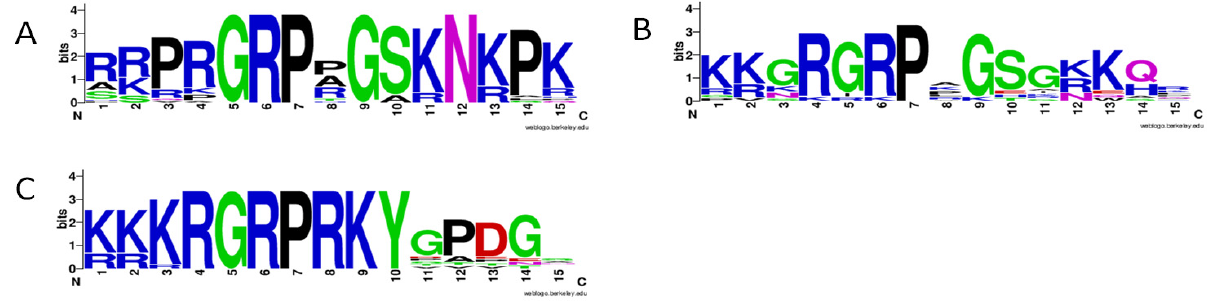
Figure 3. AT-hook motif types present in carrot AHL proteins: Type-I in Clade-A ( A ); Type-I in Clade-B ( B ); Type-II ( C